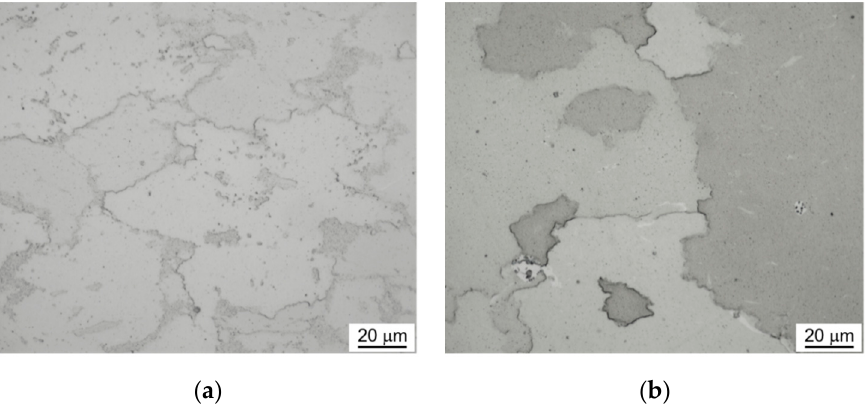
Figure 4. Effect of heat treatment on the microstructure (light microscope) of rolled OP1 ( a ) 1100 °C/20 h and ( b ) 1200 °C/20 h.